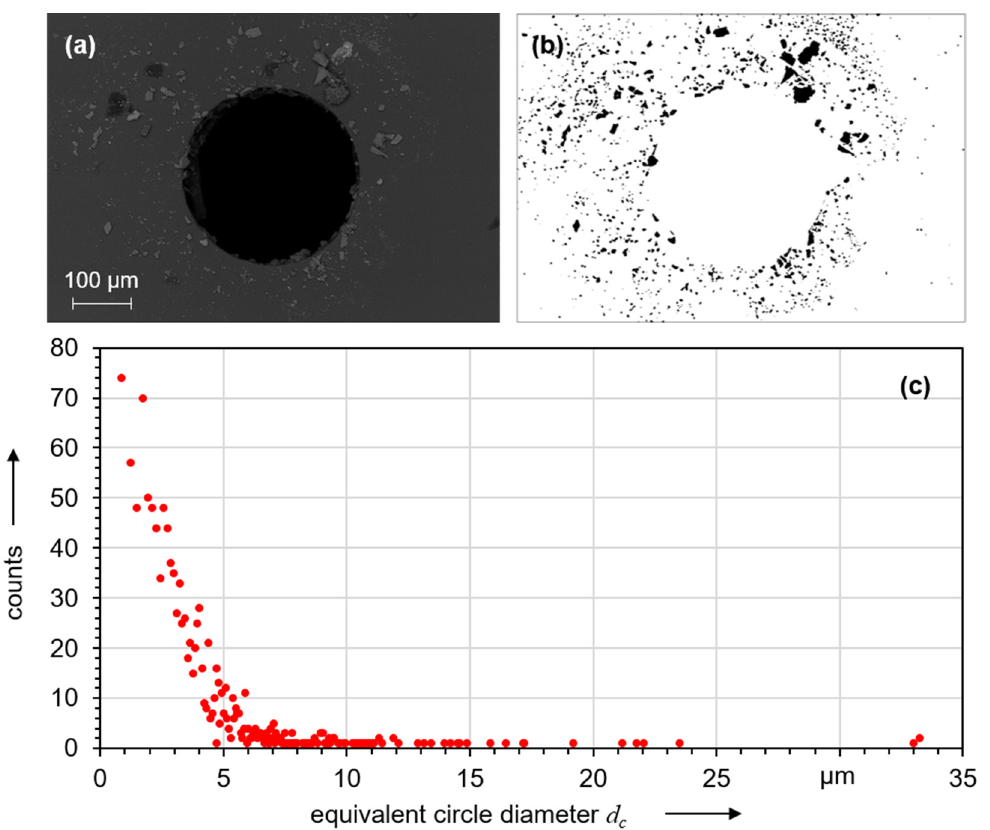
Figure 9. Binary image ( b ) generated by digital image processing from a SEM image of the orifice jewel ( a ); particle size distribution determined with the diameters of equivalent circles is shown in ( c ).